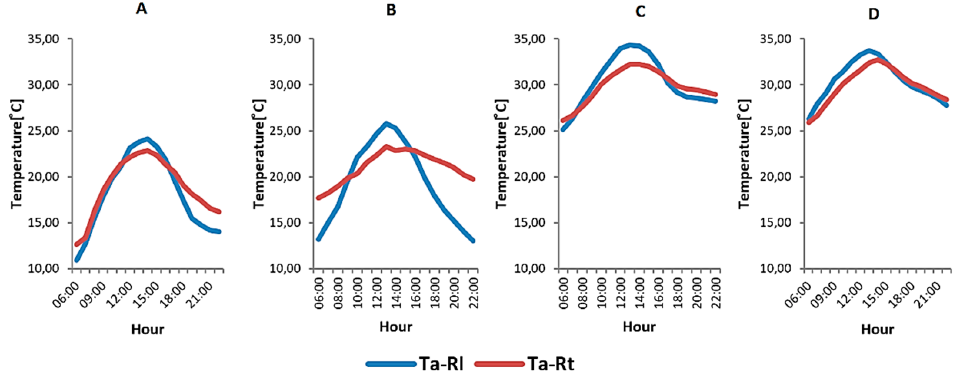
Figure 6. Measuring the transitional season from wet to dry seasons: ( A ) exposed stone houses in the mountains, ( B ) wooden houses in the mountains, ( C ) exposed brick houses in beaches, and ( D ) wooden houses on beaches.